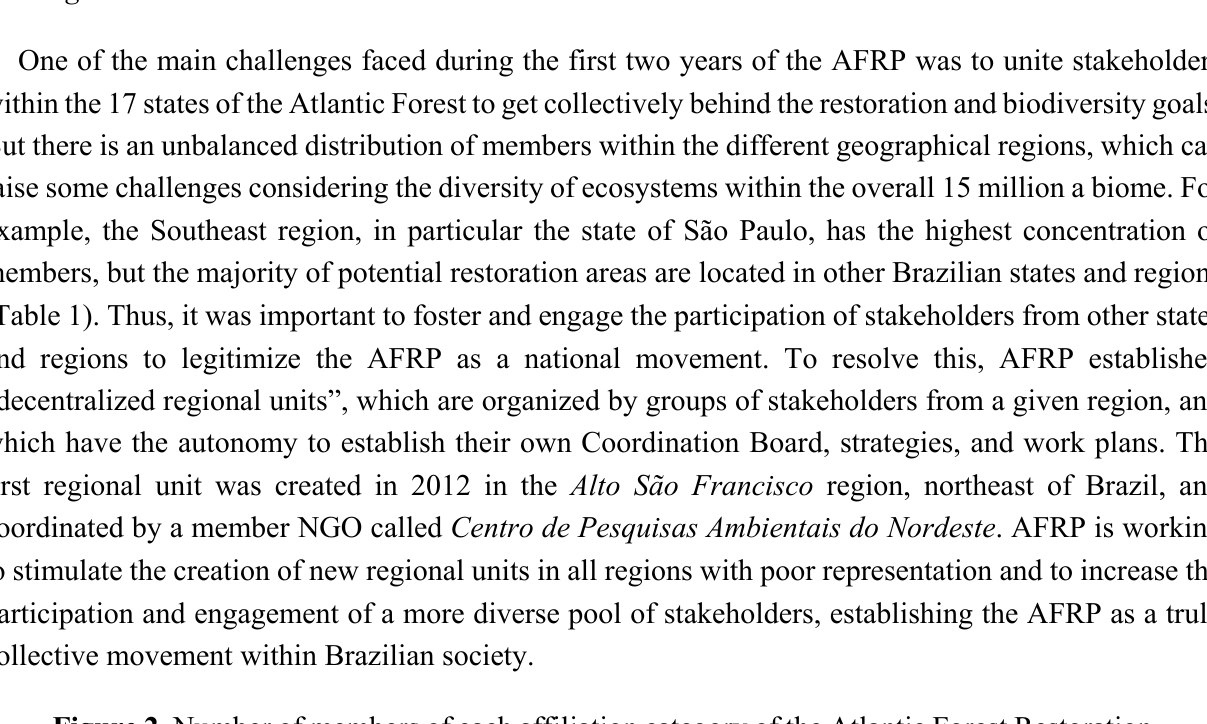
Figure 2. Number of members of each affiliation category of the Atlantic Forest Restoration Pact in 2011 and 2014; the percentage values included on the top of the bars represent the increase in the number of members in the